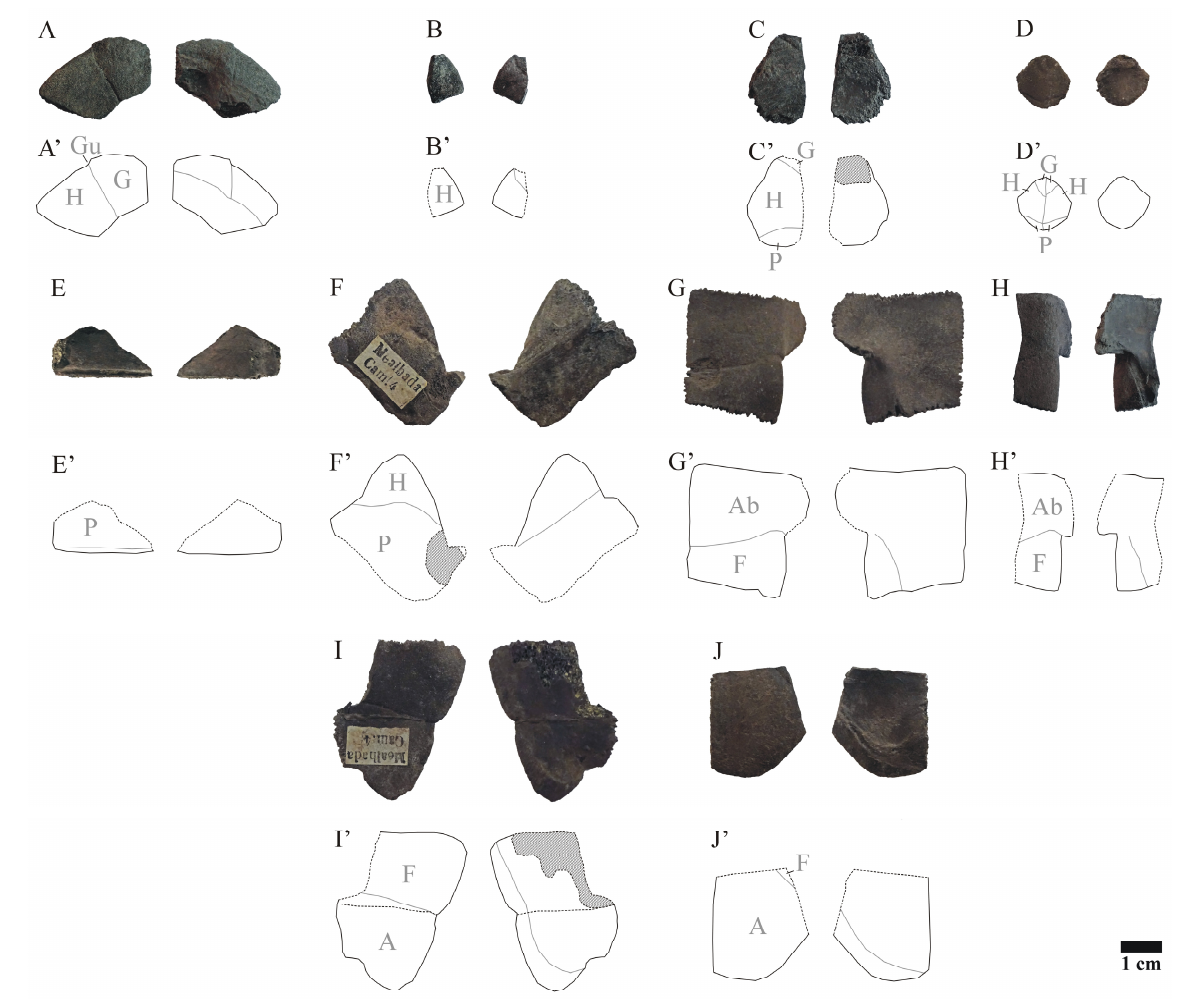
Figure 3. MG 8217.1/MG 8217.2 Plastral turtle plates selection from the Middle Palaeolithic site of Mealhada (Coimbra, central Portugal) in dorsal ( left ) and ventral ( right ) views. Mauremys leprosa plates selection ( A , C , F , G , I ): ( A ), right epiplastron; ( C ), entoplastron; ( F ), left hyoplastron; ( G ), left hypoplastron; ( I ), left xiphiplastron. Emys orbicularis plates selection ( B , D , E , H , J ): ( B ), left epiplas ‐ tron; ( D ), entoplastron; ( E ), left hyoplastron; ( H ), left hypoplastron; ( J ), left xiphiplastron. ( A’–J’ ),